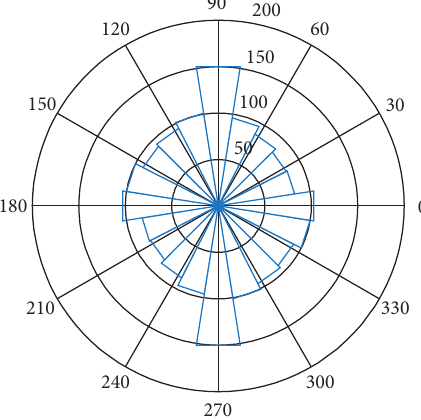
Figure 10: Rose diagram before excavation.